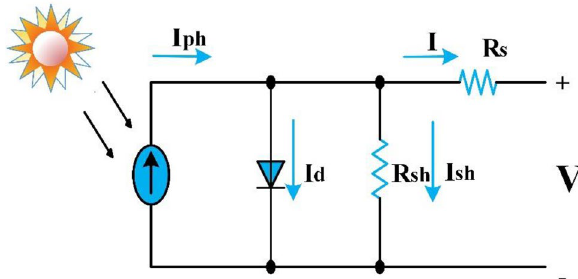
Figure 1. Single Diode PV Cell